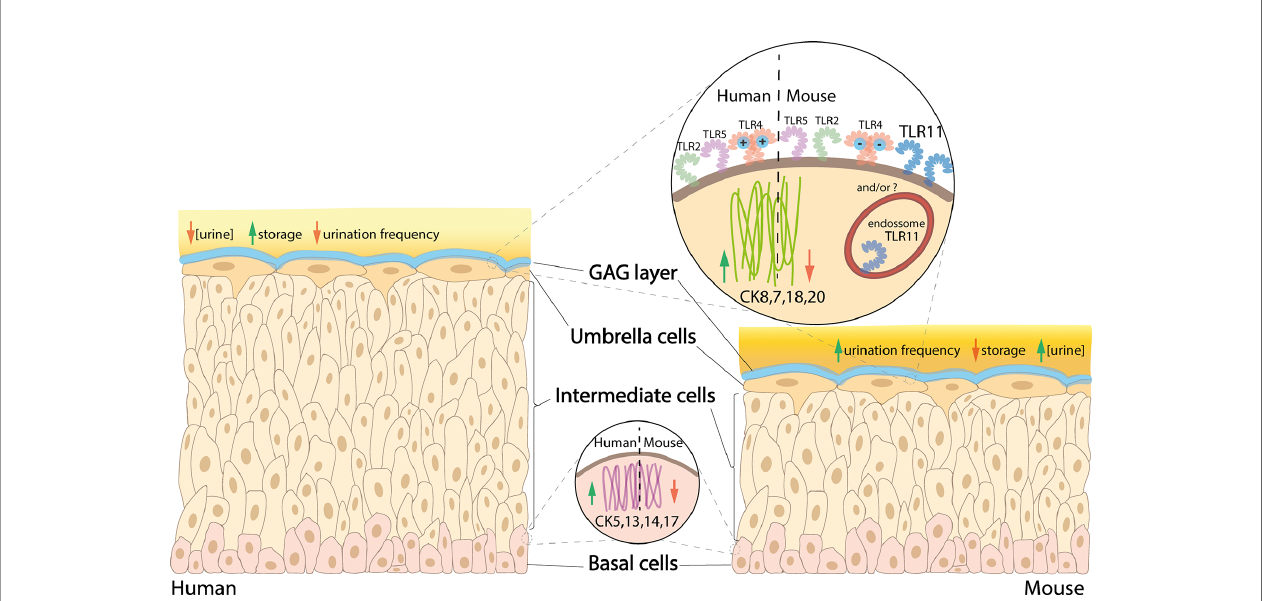
FIGURE 1 | Comparison between human versus mouse urothelium. In human bladder, basal cells have higher expression of CK5, 13, 14 and 17, intermediate cells are stacked in 5-7 layers ( vs 3-4 in mice), and umbrella cells have higher expression of CK8, 7, 18 and 20, as well as a more cationic MD-2 protein associated with the TLR4, while mice have a high expression of TLR11 (which is not present in humans). Urine is less concentrated in humans, which also have higher storage capacity and lower urination frequency compared with